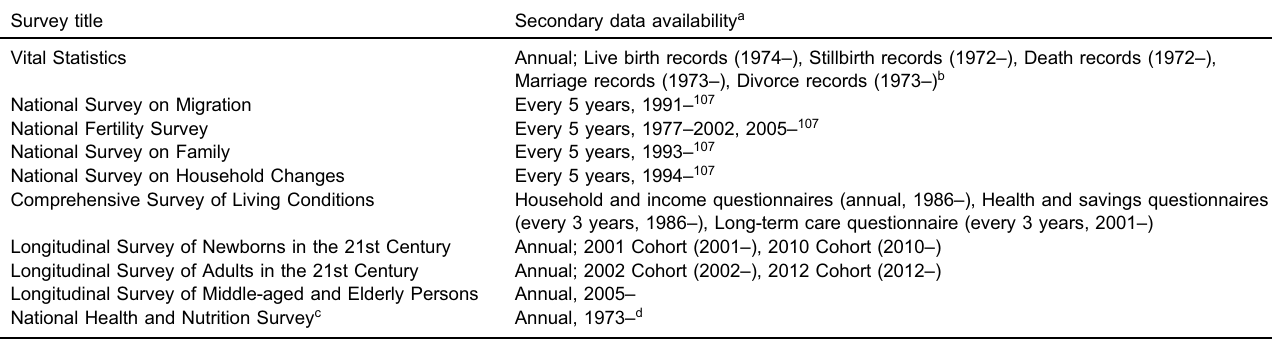
Table. Availability of secondary data of individual records from national surveys on population and health conducted on general population by the Ministry of Health, Labour and